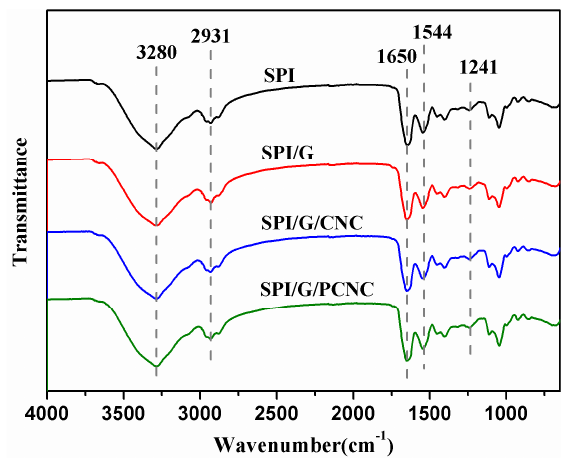
Figure 2. ATR–FTIR spectra of SPI film and SPI-based films modified with graphene, CNC, and PCNC.